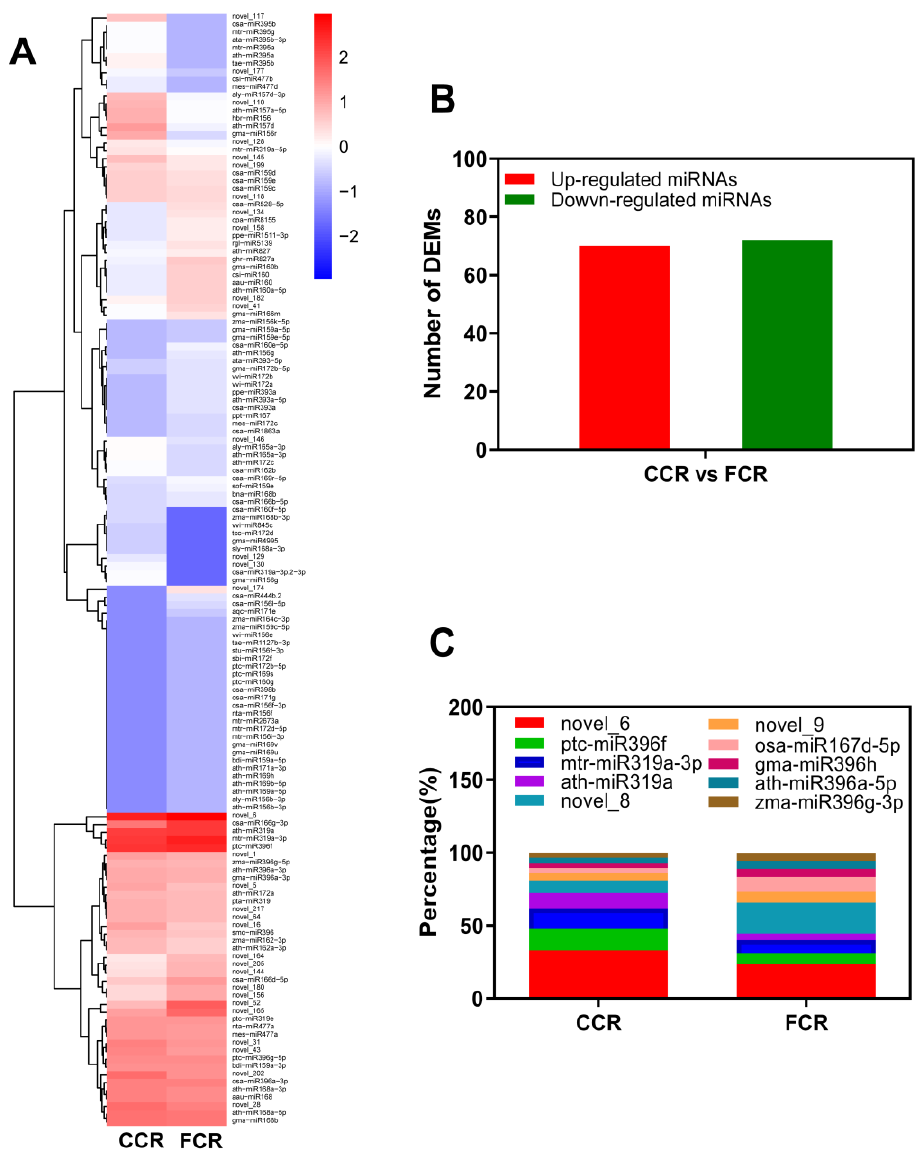
Figure 4. DEMs expression profile in different groups of kernels. ( A ) Analysis of DEMs heatmaps and clusters. ( B ) Different groups’ DEM numbers and characteristics. ( C ) Top 10 expressed miRNAs in each sample. FCC stands for the root samples of the first cropping, and CCR stands for root samples of consecutive cropping.